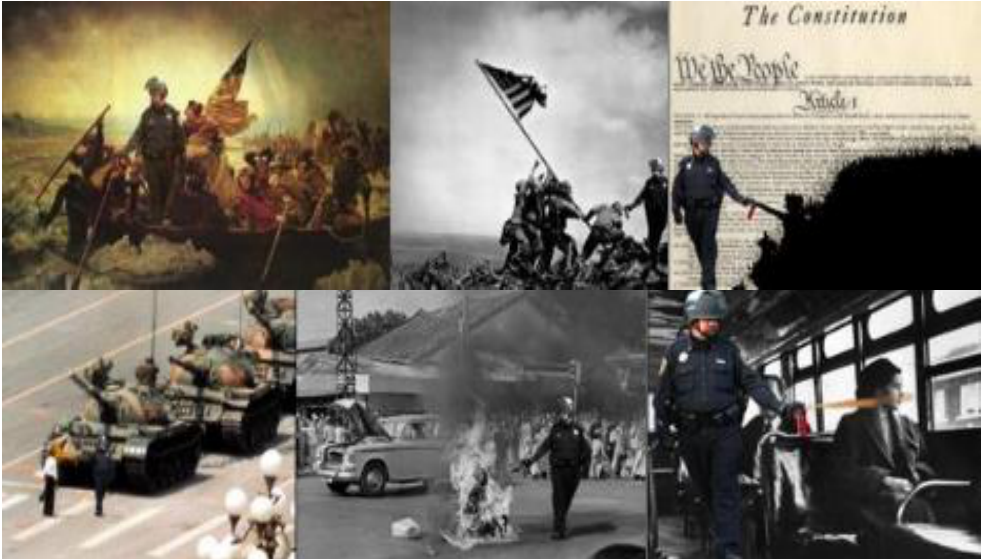
Figure 2 . “Pepper Spray Cop”